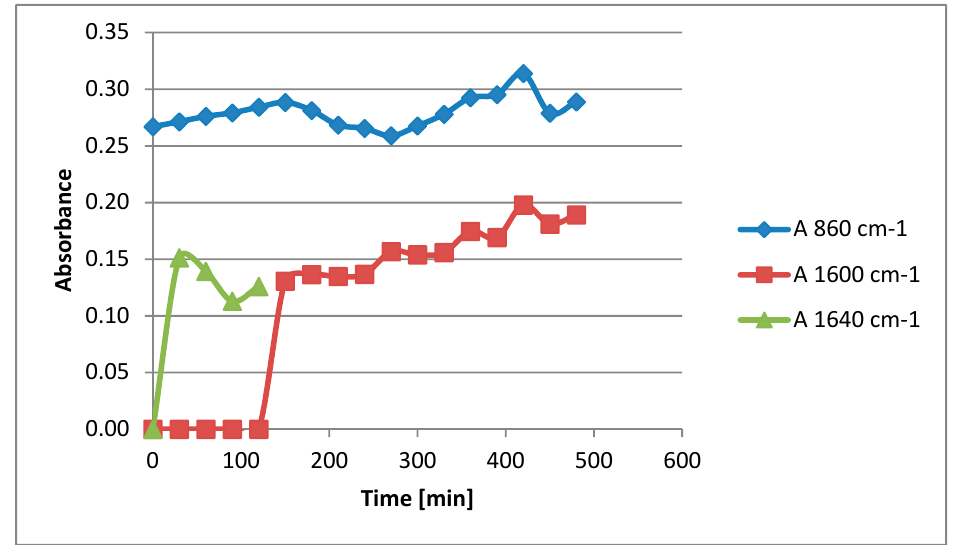
Figure 11. A plot of absorbance of the reaction time of the etherification of glycerol.